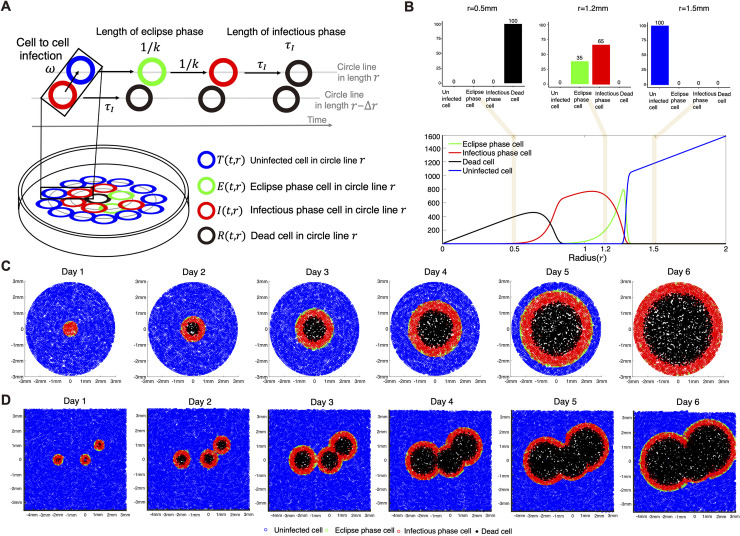
Modeling and visualizing viral plaque amplification.Modeling spatial-temporal dynamics of viral plaque amplification is shown in (A). A representative simulation for plaque amplification on day 3 is shown in (B). The ratio of cells for each radius (e.g., 0.5mm, 1.2mm and 1.5mm) can be calculated in the top panels. In (C), a representation of a single viral plaque amplification is described for each day. Merging of three plaques can be also described by considering overlapping portions over time in (D).